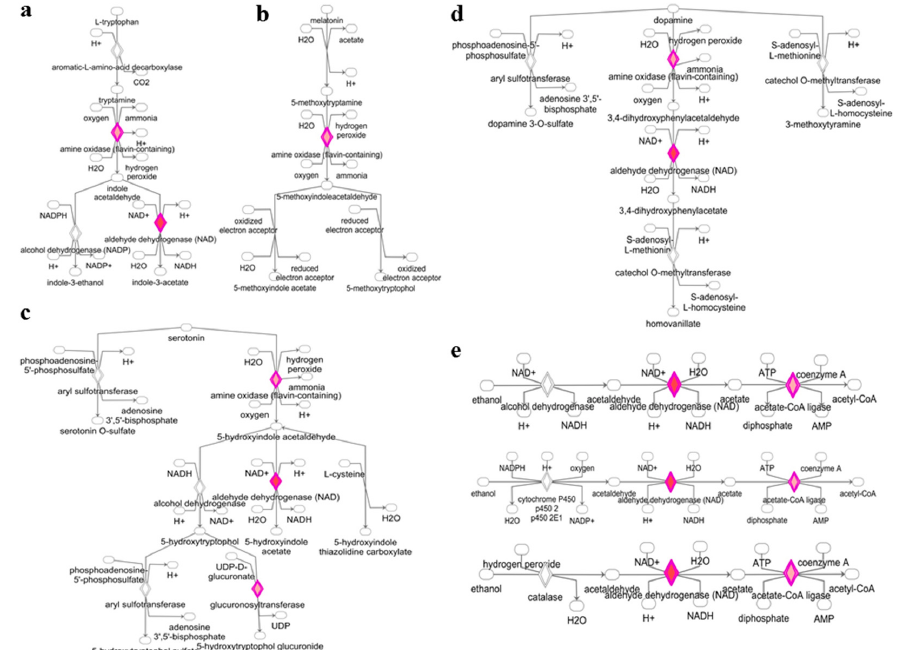
Figure 4. Alteration of biomolecule synthesis and degradation pathways in Rag2 KO mice ( a ) Upregulation of the L -tryptophan degradation signaling; ( b ) Upregulation of melatonin degradation signaling; ( c ) Upregulation of the serotonin degradation signaling; ( d ) Upregulation of the dopamine degradation signaling; ( e ) Upregulation of the ethanol to acetyl-coA conversion signaling.